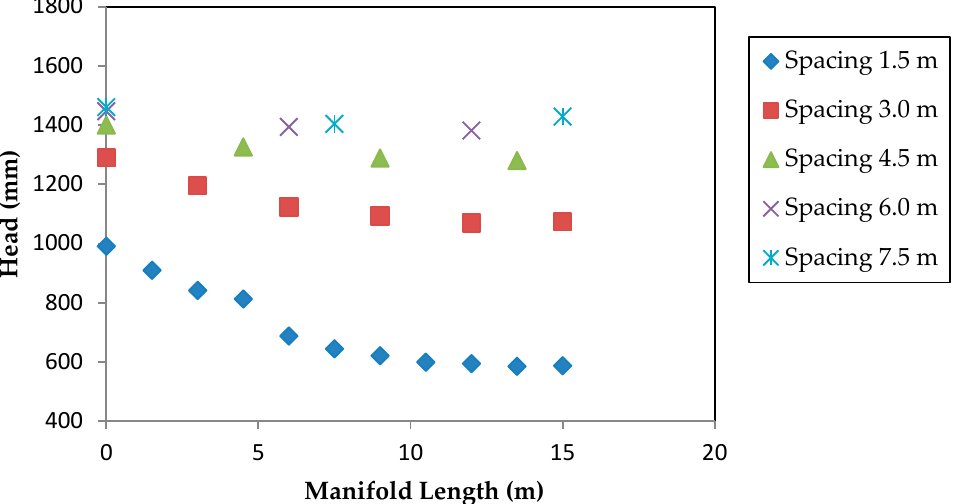
Figure 3. Variation of pressure head data with different outlet spacing (inlet head = 1.7 m, AR = 0.24).